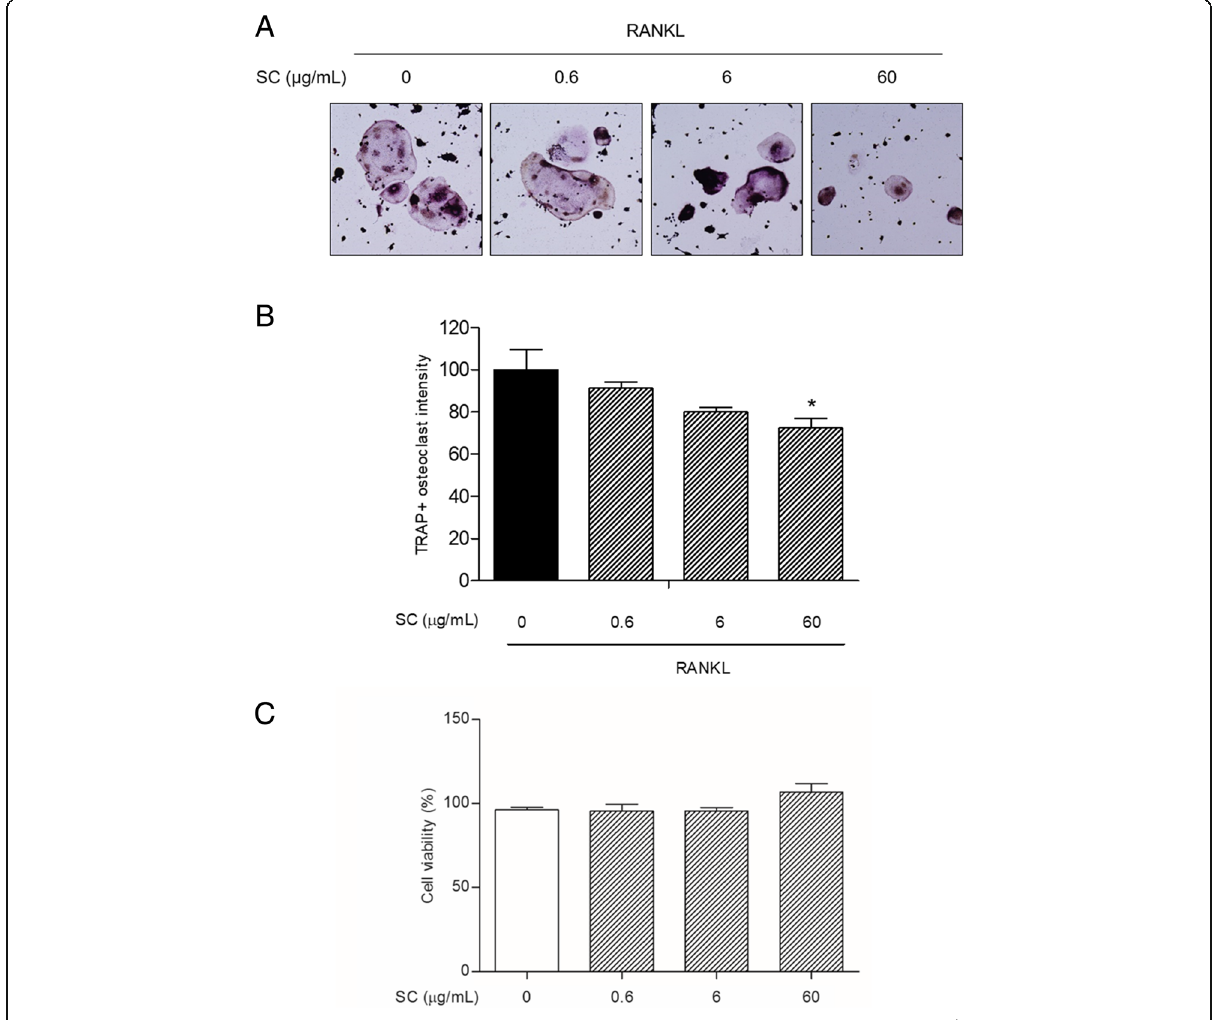
Fig. 1 The effects of SC on osteoclast differentiation in RANKL-stimulated RAW 264.7 cells. a RAW 264.7 cells (8 × 10 4 per well) were incubated with 100 ng/mL RANKL or both RANKL and SC (0.6, 6 and 60 μ g/mL) for 7 days and then stained for TRAP. Magnification, 100× original. b TRAP activity was measured using an ELISA reader (optical density, 410 nm). Data are represented as the means ± S.E.M. of three independent experiments. * p < 0.05 compared with only RANKL-treated cells. c Cell viability was confirmed by MTT